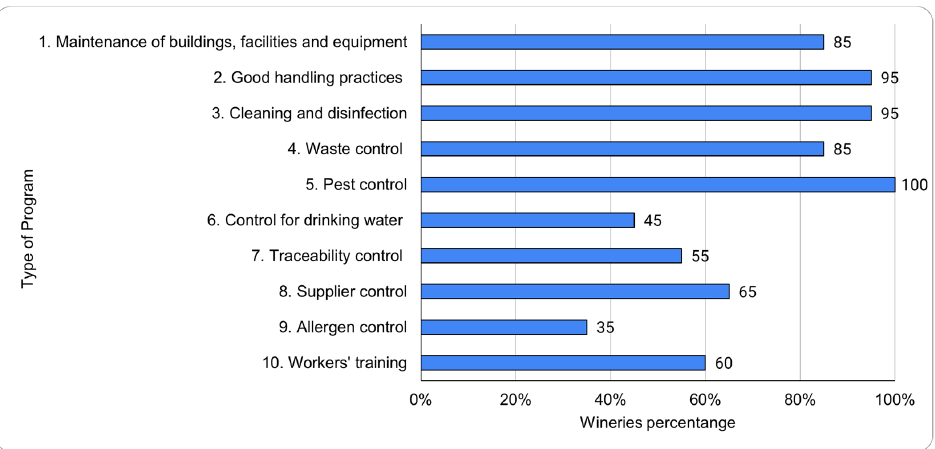
Figure 1. Percentage of wineries that have implemented each type of program included in a standard prerequisites program (PPRs).